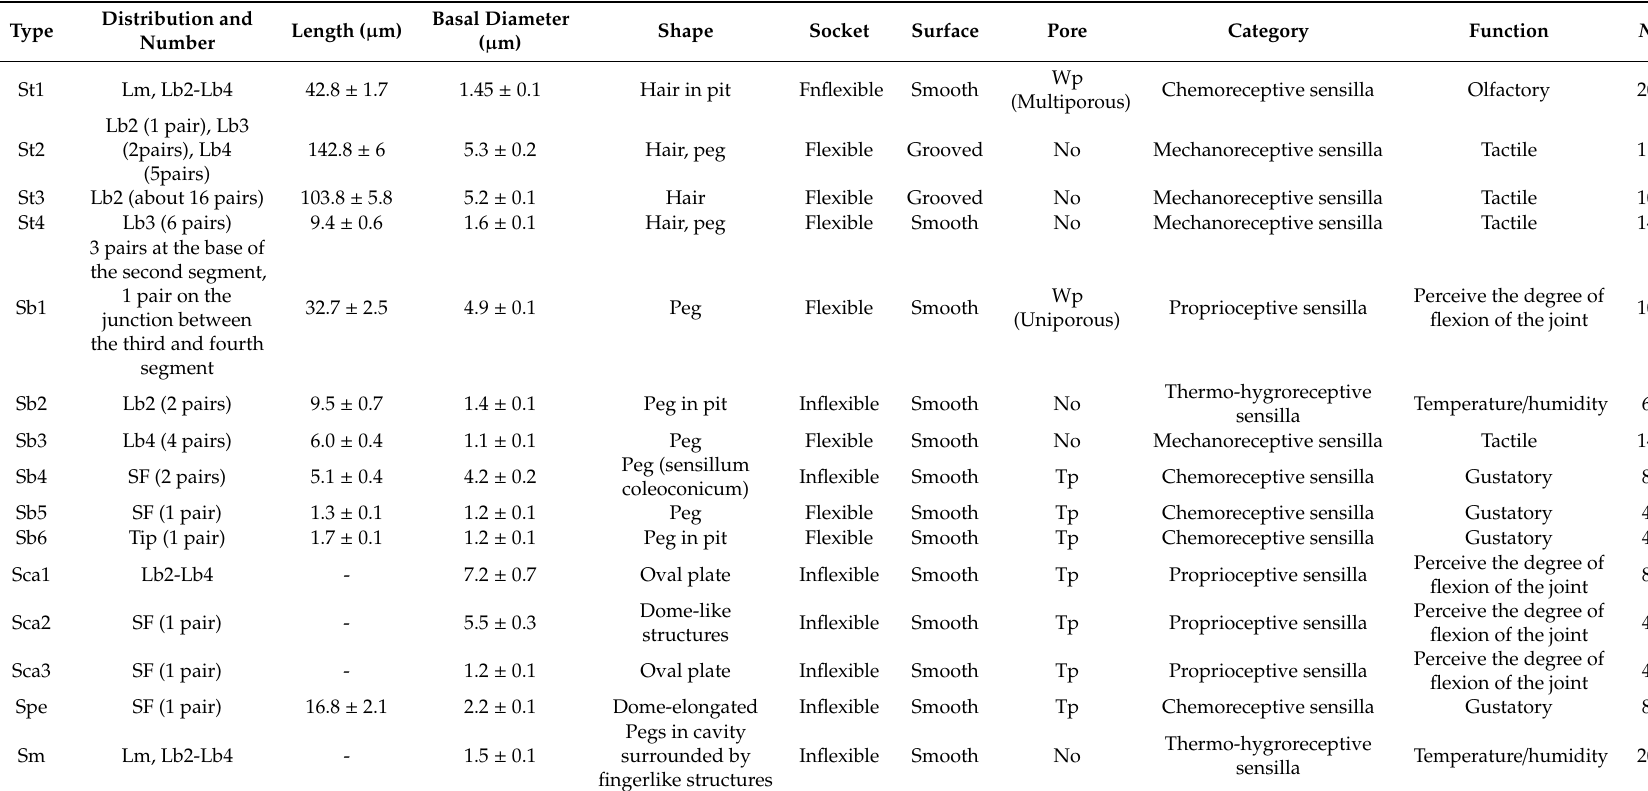
Table 2. Distribution, morphometric data (mean ± SE), terminology and definition of sensilla used in the present paper after data of prior authors [18,48,49]. Lb2, 3, 4, the second, third, fourth segment of labium; Lm, labrum; N = sample size; St1–4, sensilla trichodea I-IV; Sb1–6, sensilla basiconica I-VII; Sca1–3, sensilla campaniformia; Spe,placoid elongated sensilla; Sm, multilobular sensilla; SF, sensory field on the labial tip; Wp, wall pore; Tp, tip